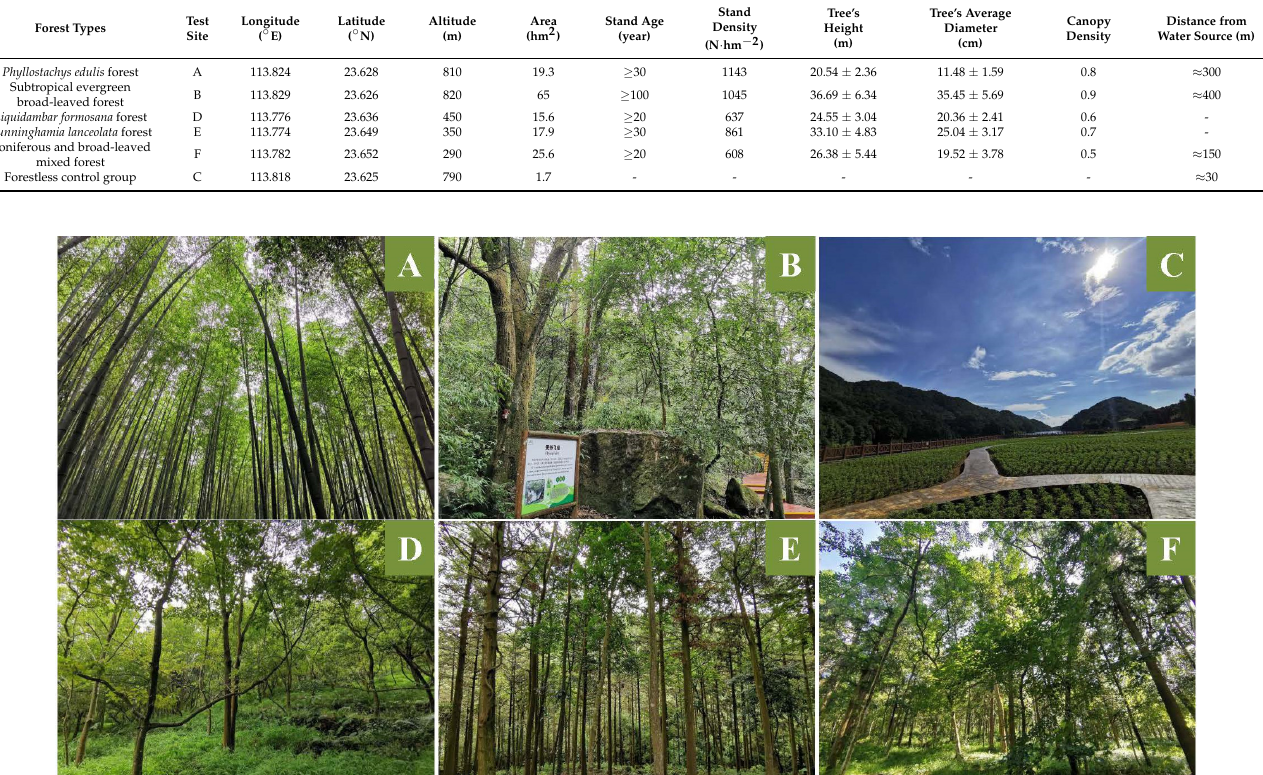
Table 1. Overview of the sample plots.